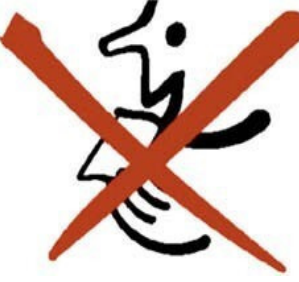
Figure 6. Symbol for ‘non-edible’ parts in active and intelligent material labeling (Regulation EC 450/2009) [96].